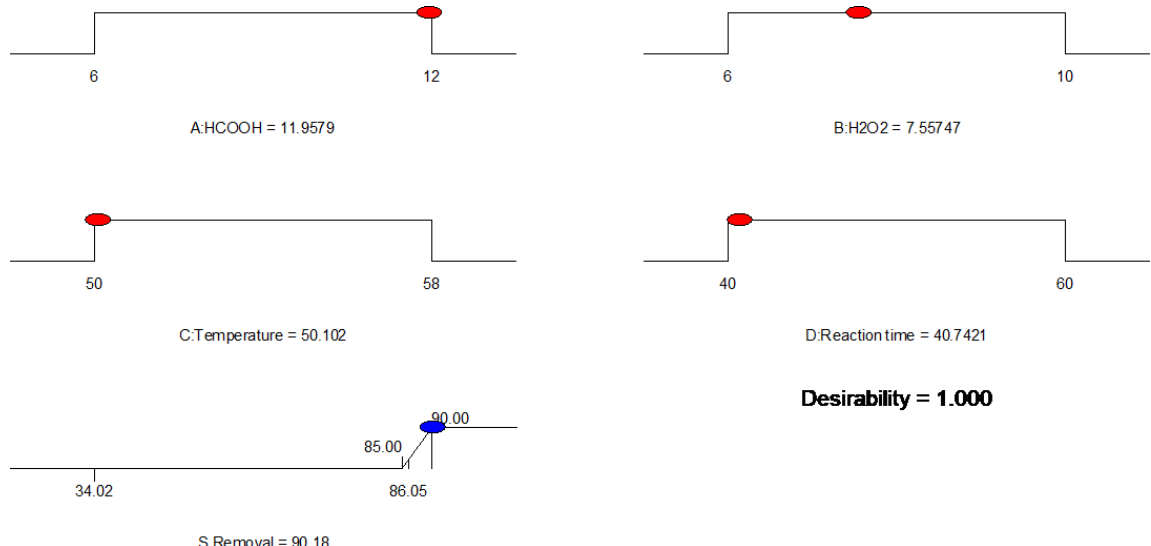
Figure 11: Predicted numerical optimisation ramps for targeted sulphur removal.